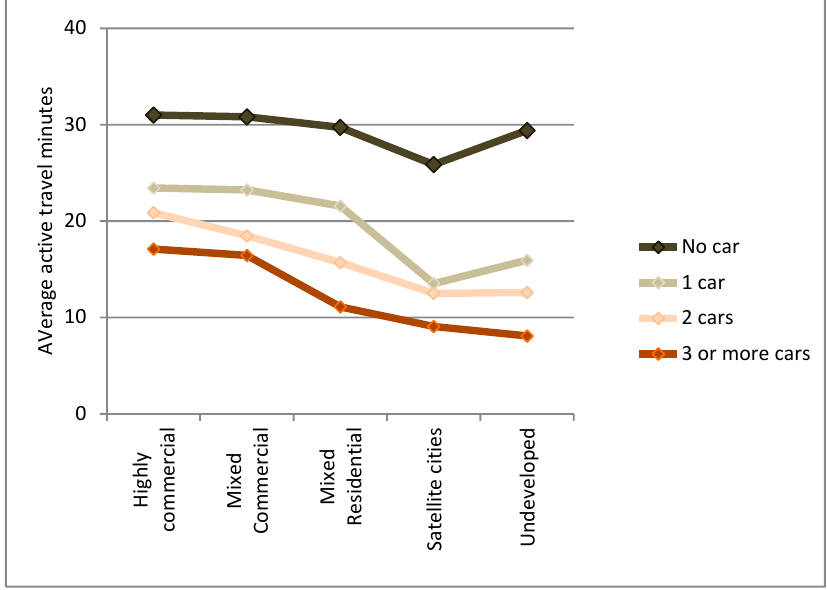
Figure 10. Changes in average active transport time per person for car ownership by built environment type.